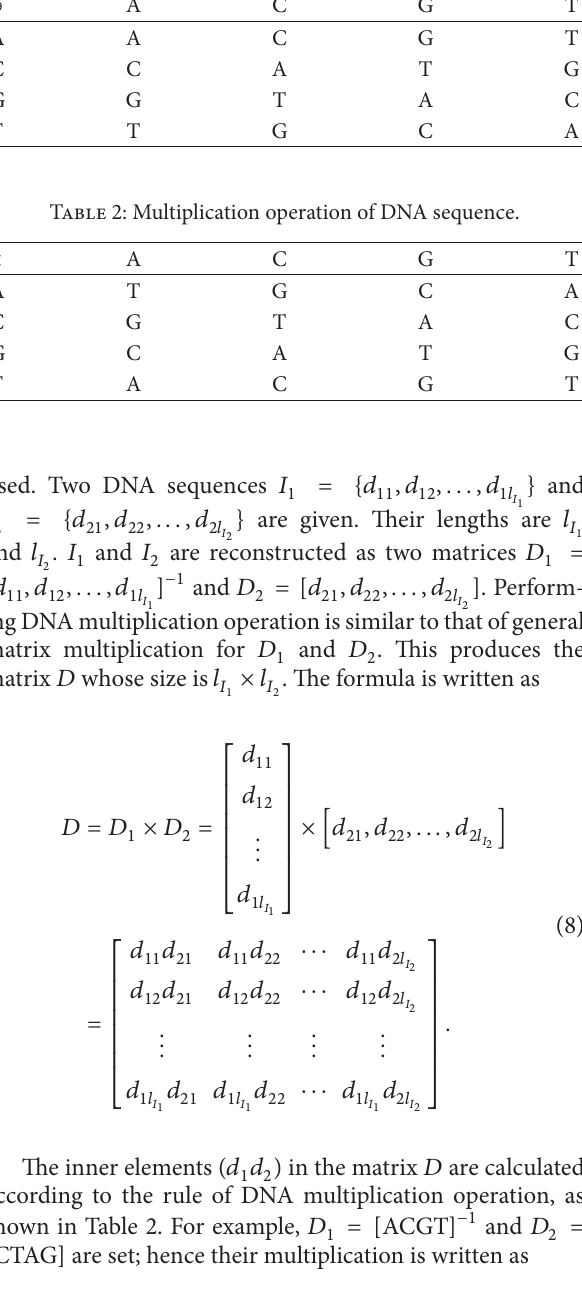
Table 1: XOR operation of DNA sequence.